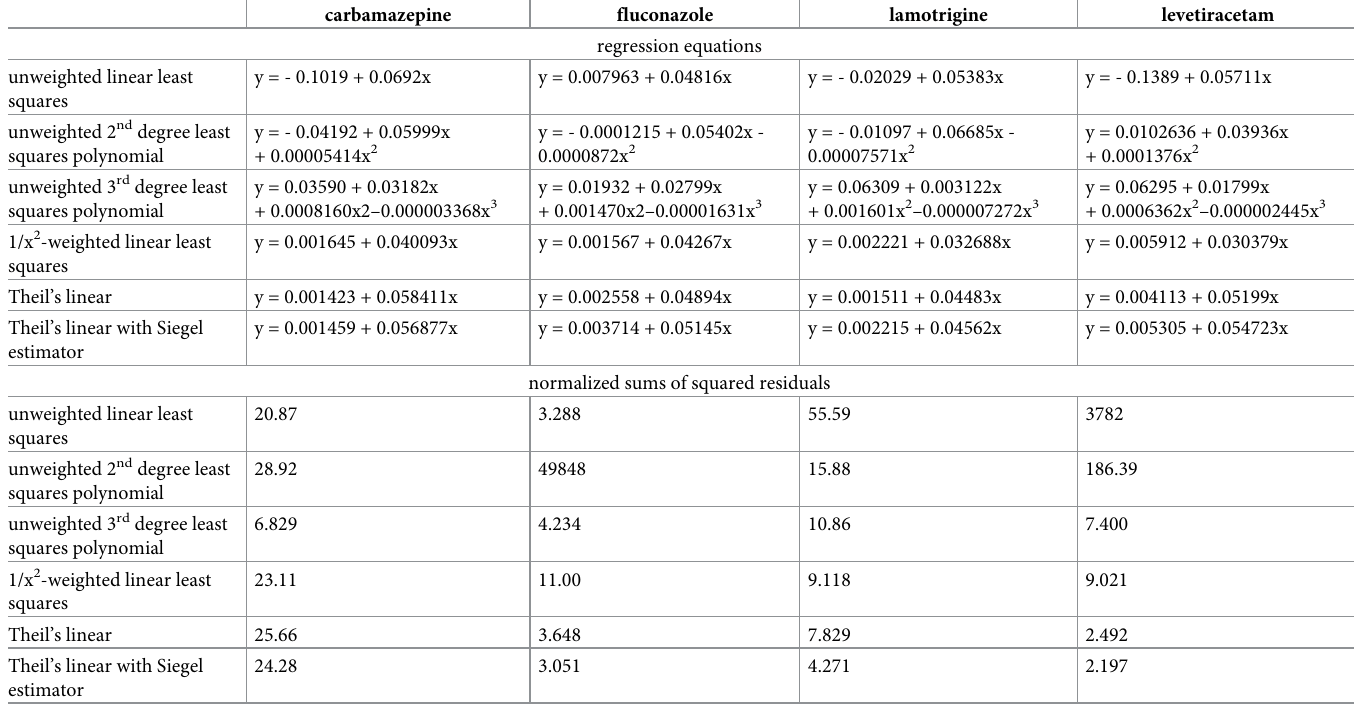
Table 5. Regression equations and the normalized sums of squared residuals obtained applying various regression algorithms to the combined results of the 3 experiments performed on carbamazepine, fluconazole, lamotrigine and levetiracetam (N = 24 specimens/spiking level, M = 20 spiking